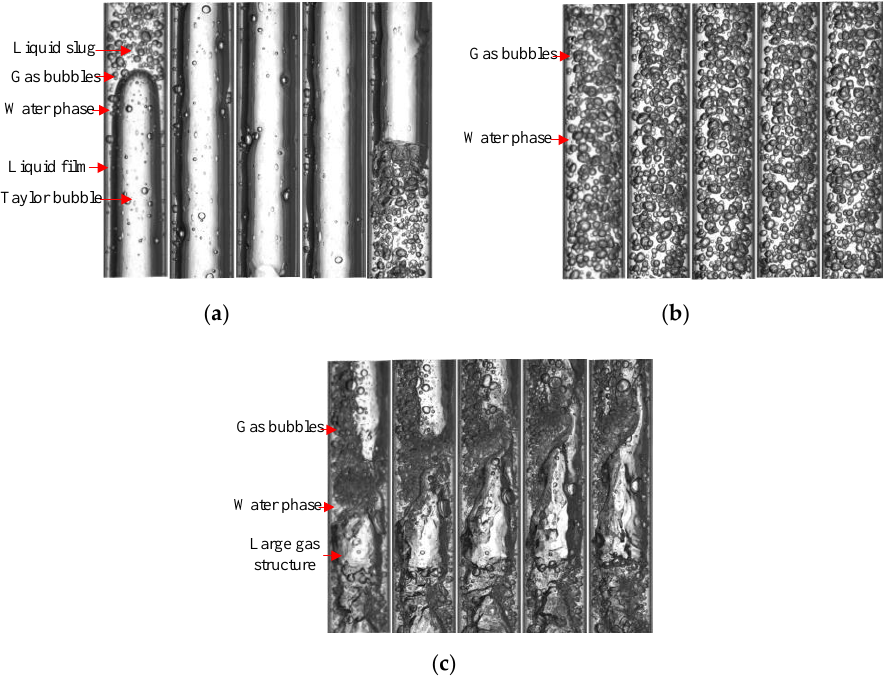
Figure 5. The images of three typical flow patterns: ( a ) Slug flow; ( b ) Bubble flow; ( c ) Churn flow.